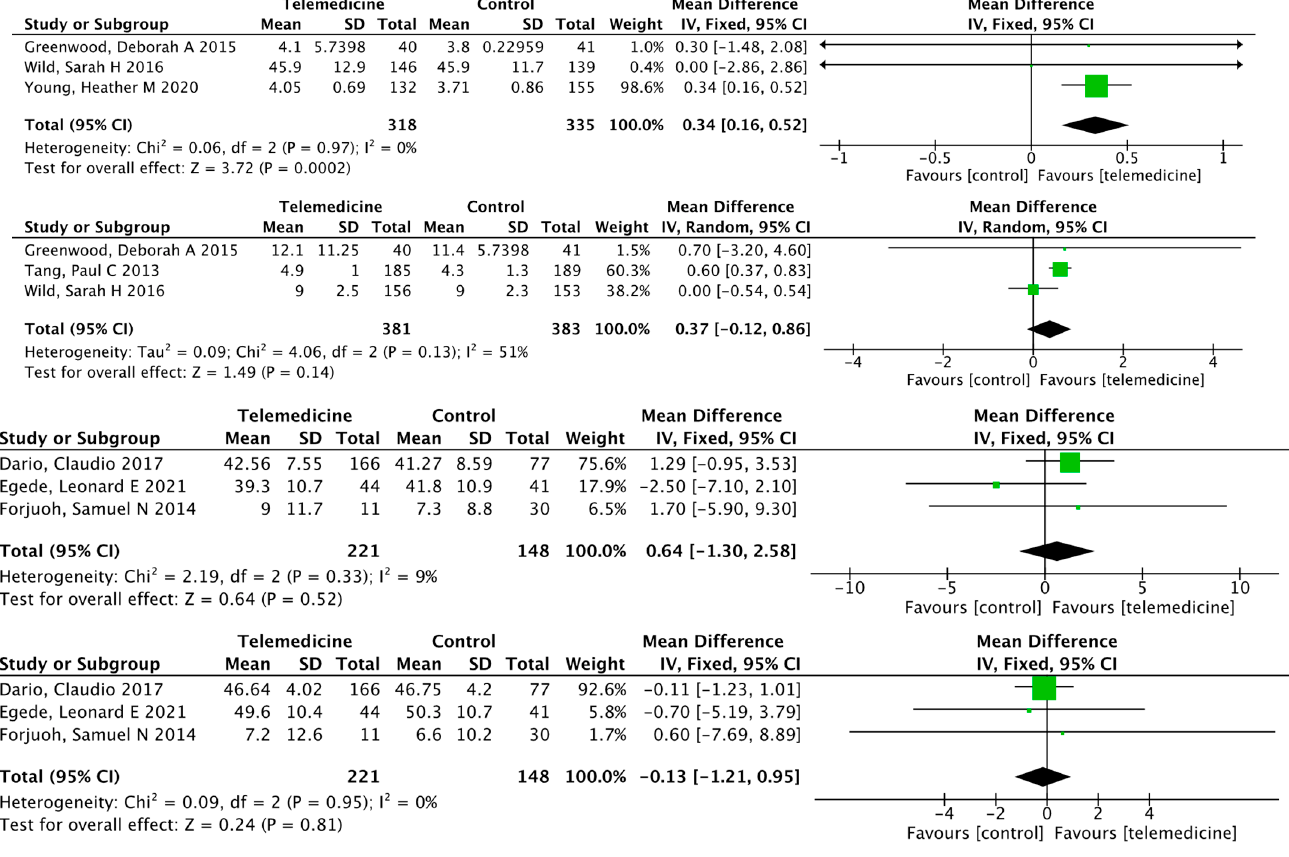
Figure 11. Mean difference in the changes in self-efficacy, diabetes knowledge, physical health, and mental health levels for telemedicine and usual care interventions.